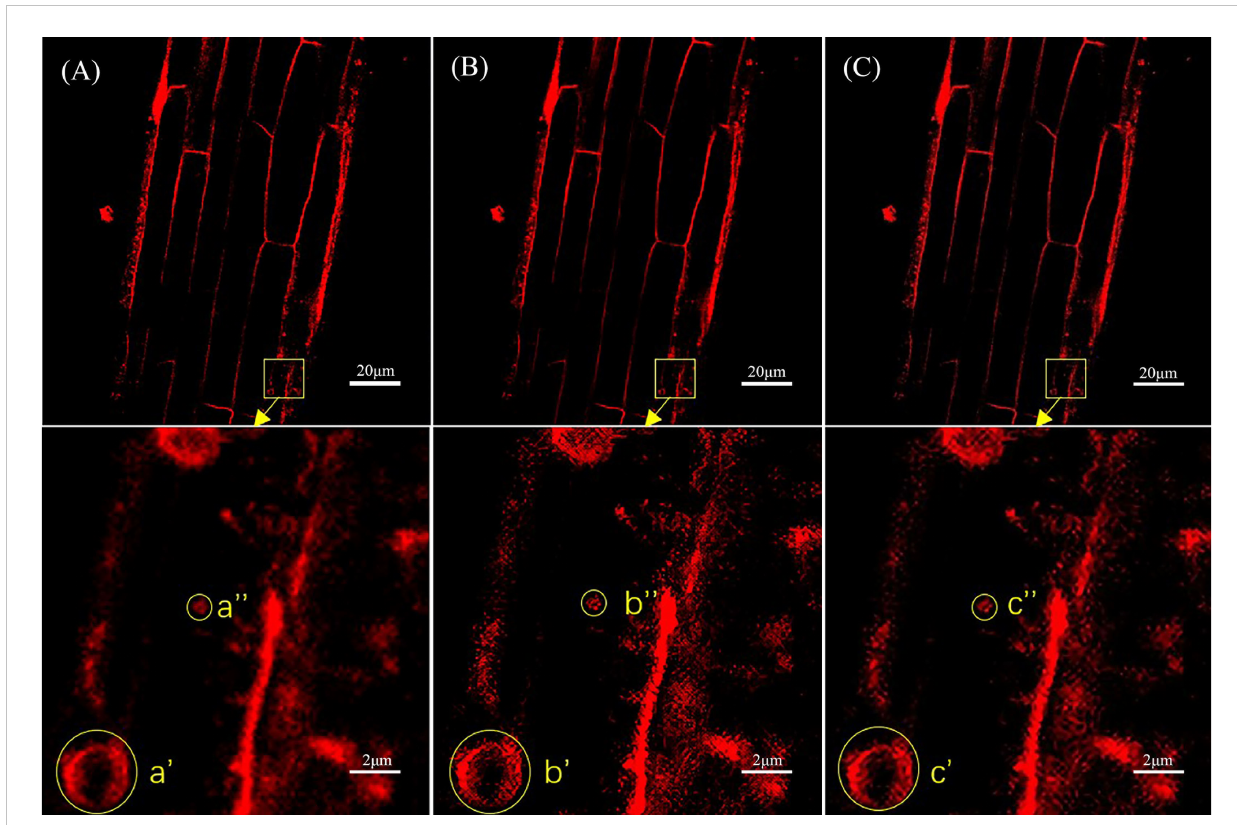
FIGURE 4 Comparison of the three types of images of Solanum nigrum root cells containing endocytic vesicles. (A) Original image(pixel: 1024×1024) and local magni fi cation map(pixel: 102×102). (B) SRGAN single-reconstruction image(pixel: 4096×4096) and local magni fi cation map(pixel: 410×410).